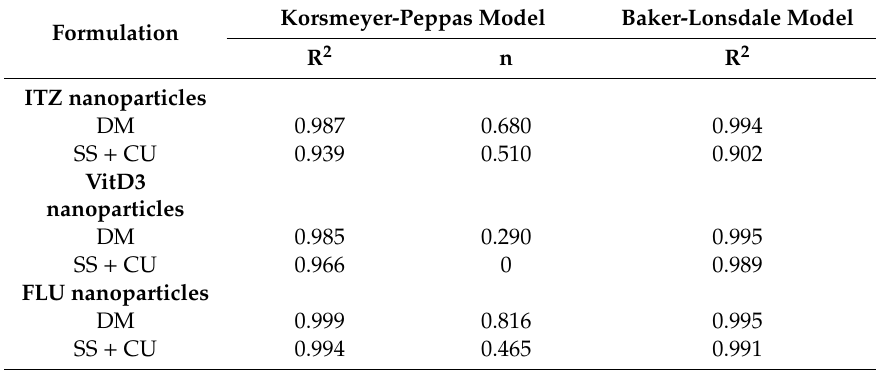
Table 5. The value of R 2 and exponent (n) for modeling of release